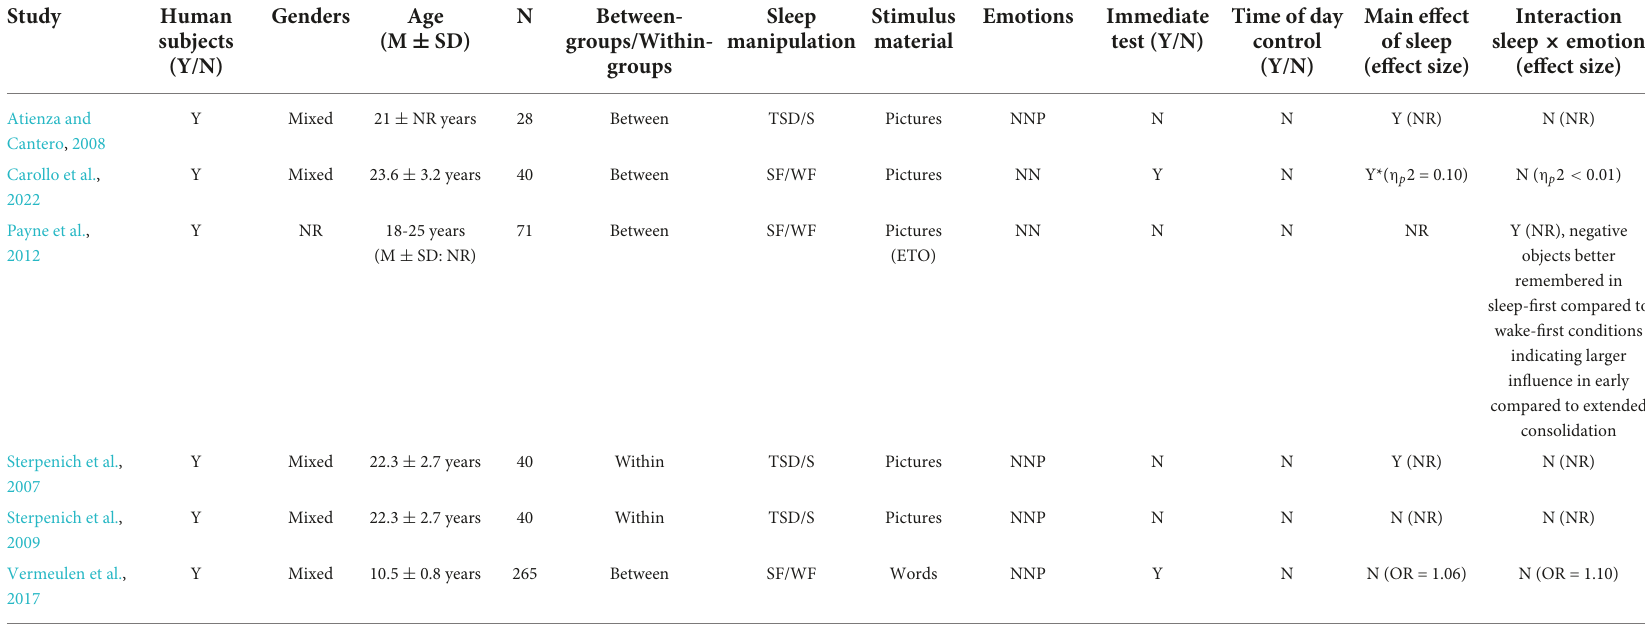
TABLE 2 Studies aimed at investigating the effect of sleep on the extended consolidation phase of emotional memory